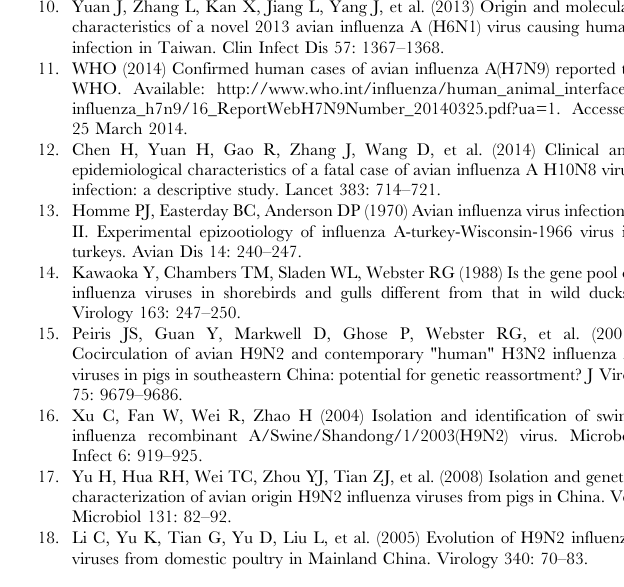
Figure S3 Characterization of the receptor-binding properties of H9N2 viruses. The binding of the viruses to two different biotinylated glycans ( a -2, 3 glycan, blue; a -2, 6 glycan, pink) was tested. The data shown are the means of three repeats; the error bars indicate the standard deviations. Figure S4 Histological lesions caused by H9N2 viruses in the lungs of ferrets. Ferrets were euthanized on day 4 p.i. with 10 6 EID 50 of test virus, and the lungs were collected for pathological study. The lungs of DK/ZJ/C2046/12 virus- inoculated animal showed only mild histopathological changes (H&E staining,) ( A ), whereas the lungs of CK/HuN/C4136/10 ( B ), CK/CQ/C1258/11 ( C ), CK/HuB/C4196/09 ( D ), CK/ZJ/ SC324/13 ( E ), and CK/SH/SC197/13 ( F ) virus-inoculated ferrets showed severe pathological lesions (H&E staining). Viral antigen was detected in the epithelial cells of bronchus and alveoli